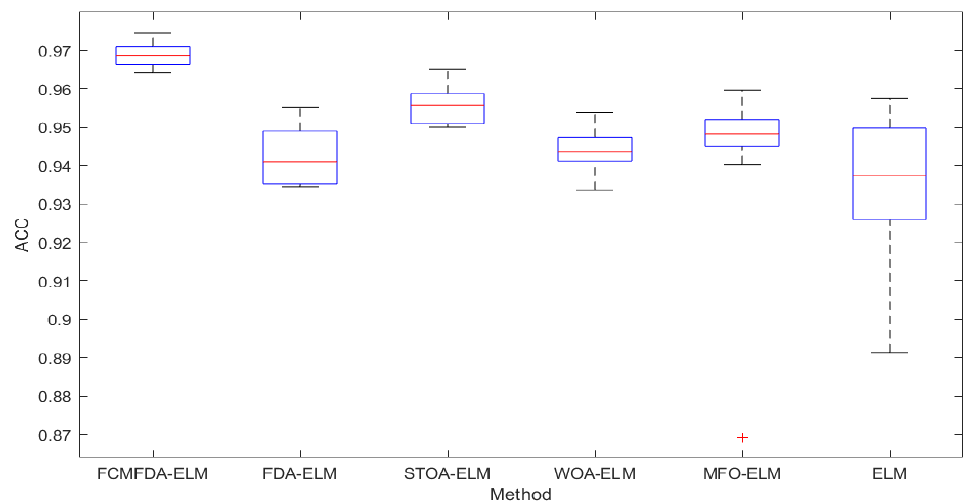
Figure 17. Box graph of each classification algorithm (URPC).